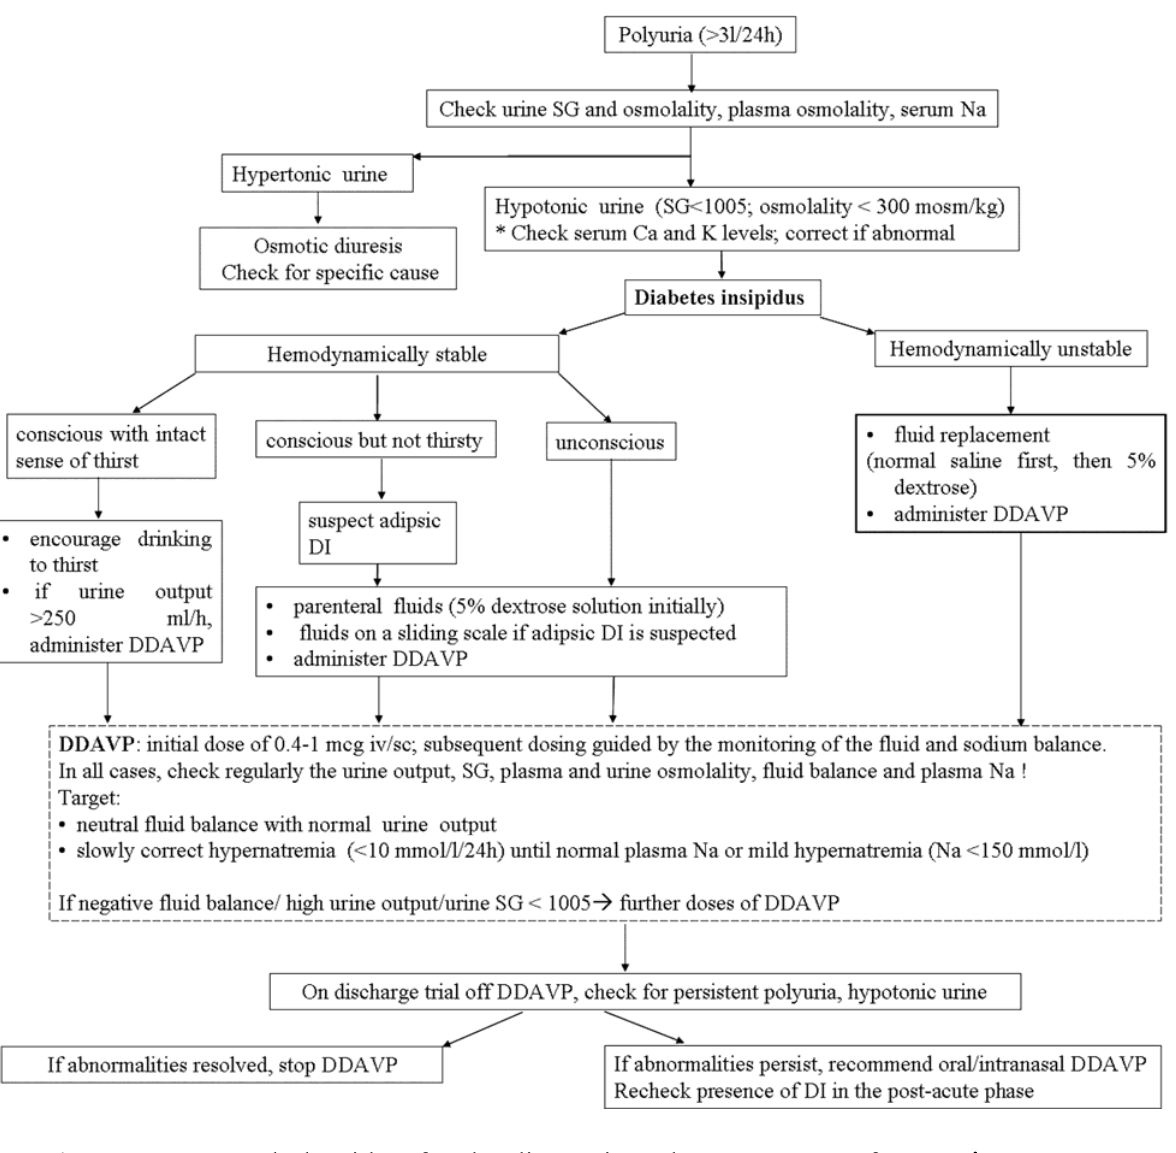
Figure 1. Proposed algorithm for the diagnosis and management of PTDI iv- ntravenous; sc